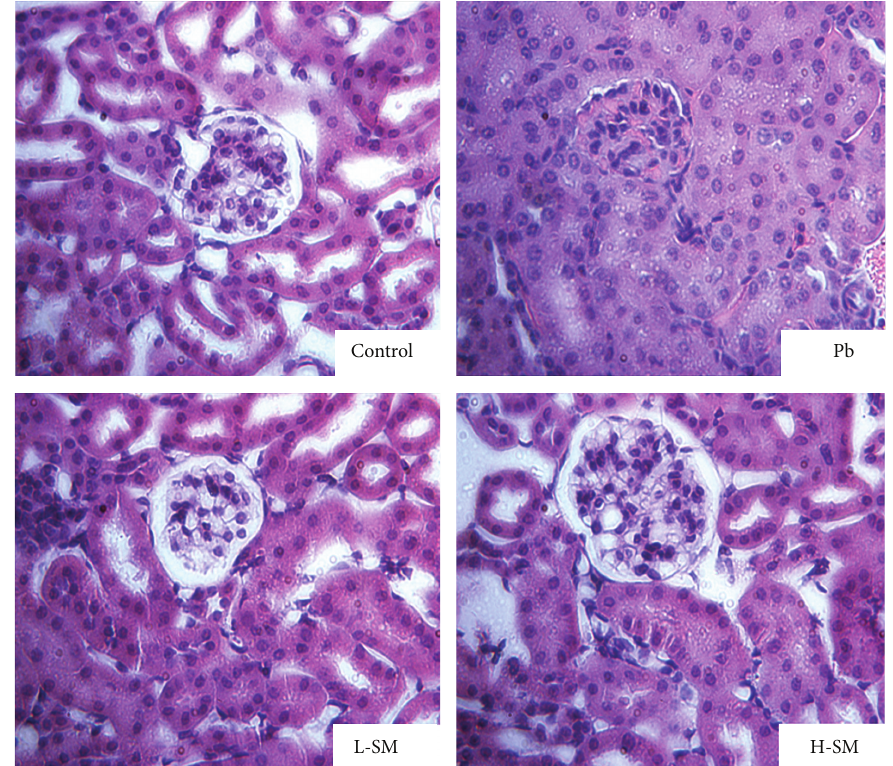
Figure 3: Effects of SM injection on histopathological changes stained with H&E. Representative microscopic photographs of kidney stained with H&E (magnification 400x). Compared to the normal morphology of kidneys in the control group, those of mice treated with Pb acetate displayed marked histological changes in the cortex and remarkable swelling in the proximal tubular epithelial cells, as well as diminishing glomeruli of the kidney. Although SM-treated mice showed some enlargement of proximal tubular epithelial cells, theglomerulus architecture was normal compared with the Pb